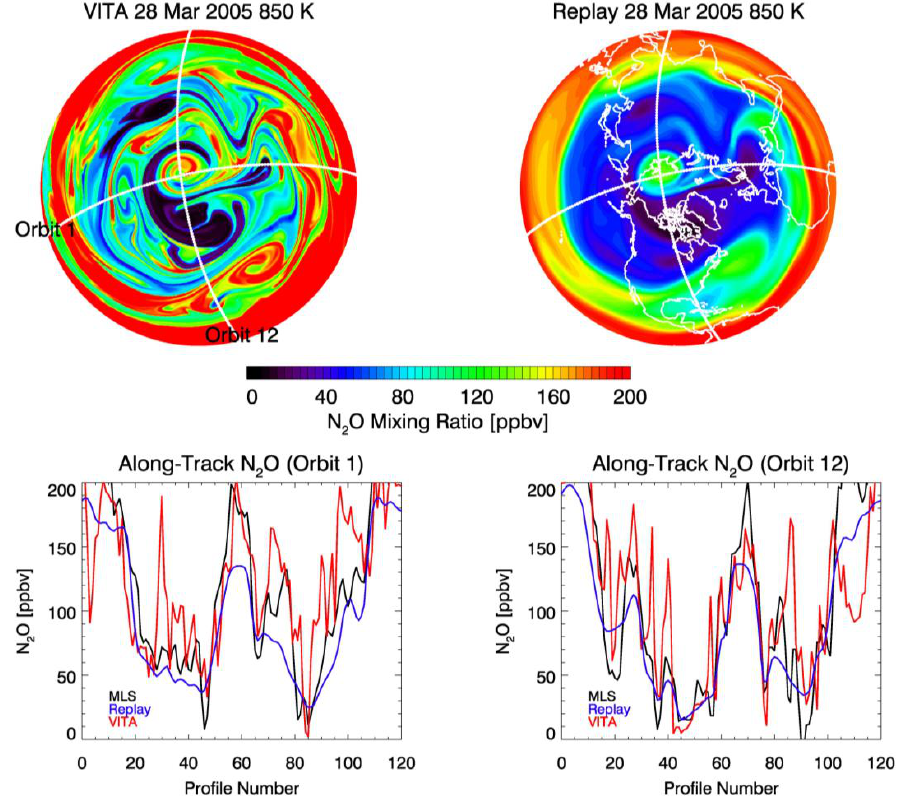
Fig. 5. Top row: Northern Hemisphere VITA (left) and Replay (right) N 2 O at 850K on 28 March 2005. Red (blue) indicates high (low) N 2 O values. Overlaid are two EOS Aura MLS orbit tracks for this day. Second row: MLS (black), Replay (blue), and VITA (red) N 2 O at 850K along the selected orbit tracks. The profiles start at the locations of the orbit labels in the upper left panel. Replay and VITA data are interpolated linearly in space and time to the MLS data points.